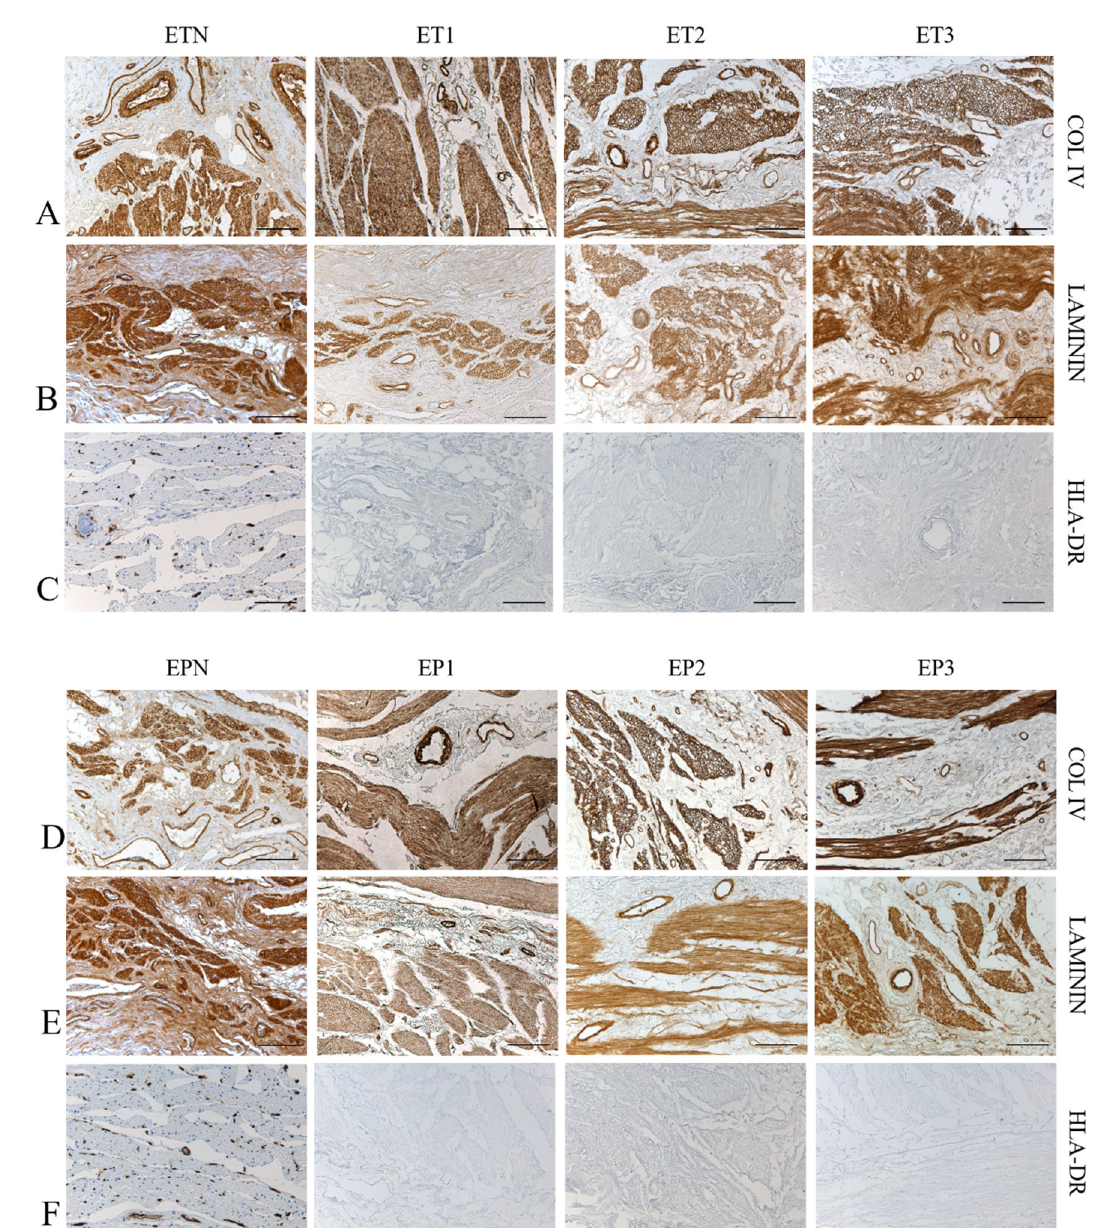
Figure 3. Preservation of tissue-specific markers. Immunohistochemistry for the localization of specific ECM markers and MHC II antigens within esophageal tubules (ETs) and patches (EPs) before (ETN, EPN) and after decellularization with Protocols Nos. 1 (ET1, EP1), 2 (ET2, EP2) and 3 (ET3, EP3). Scale bars: 400 μ m ( A , D , E , H ); 200 μ m ( B , C , F , G ).